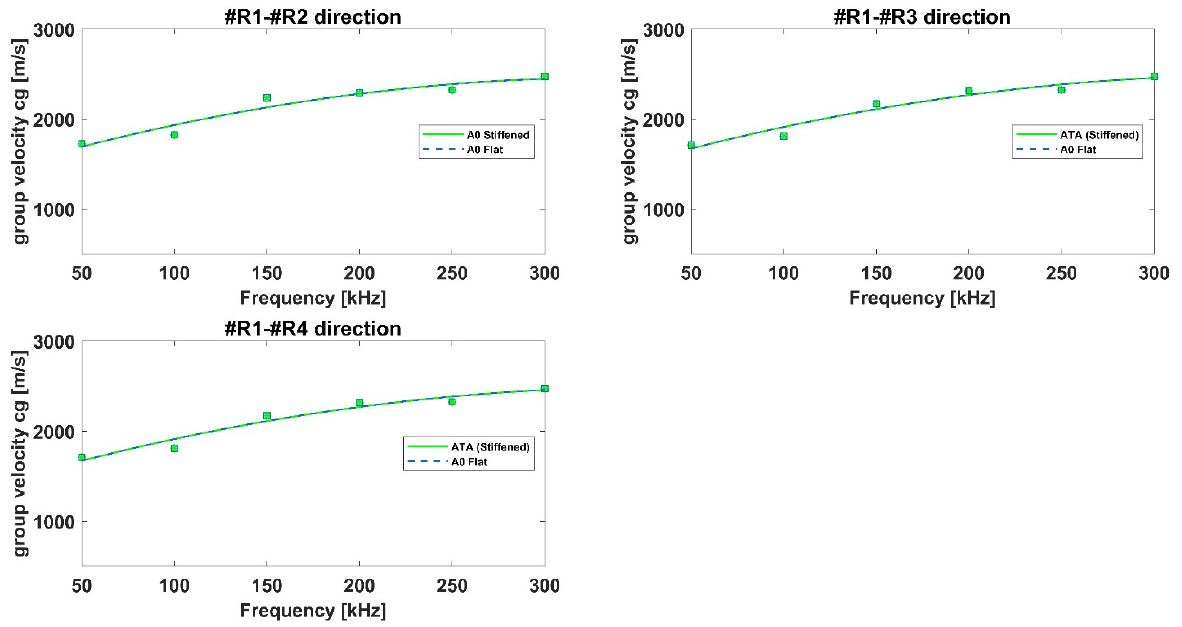
Figure 13. Comparison of the group velocities of the incident and converted/reflected A (cid:2868) modes detected in the flat and reinforced configurations – aluminum panels.